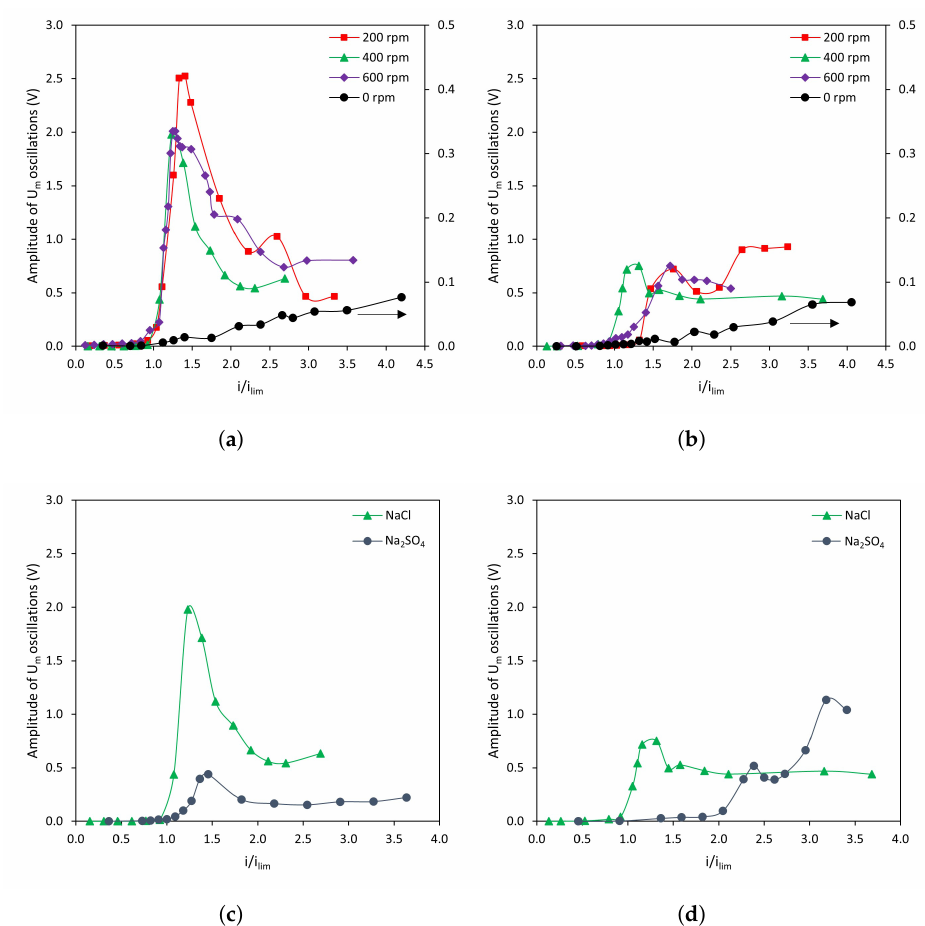
Figure 6. Evolution of the amplitude of membrane voltage oscillations at various levels of stirring rate. ( a ) AMV-N with NaCl as electrolyte, ( b ) HC-A with NaCl as electrolyte. Evolution of the amplitude of membrane voltage oscillations with NaCl and Na 2 SO 4 at 400 rpm. ( c ) AMV-N, ( d )